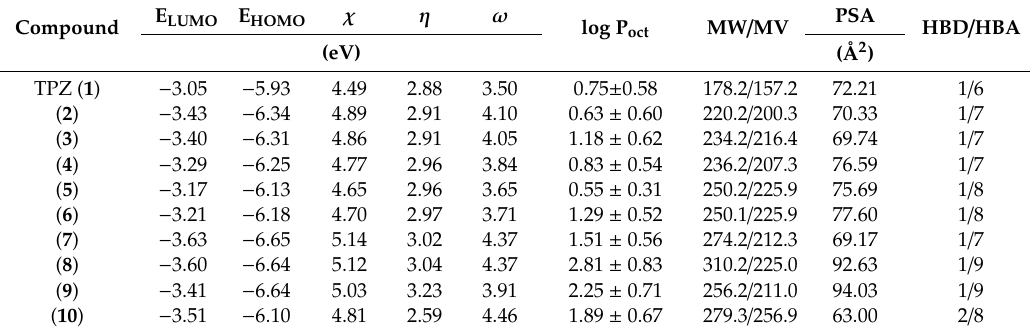
Table 2. The molecular descriptors of TPZs: LUMO (E LUMO ), HOMO (E HOMO ) energies, global electronegativity ( χ ), global hardness ( η ), global electrophilicity ( ω ), molecular weight (MW), molecular volume (MV), octanol / water partition coe ffi cient (Log P oct ), polar surface area (PSA), H-bond donor (HBD) and H-bond acceptor (HBA) counts. The Log P values represent the average of the five determinations as described in the Experimental